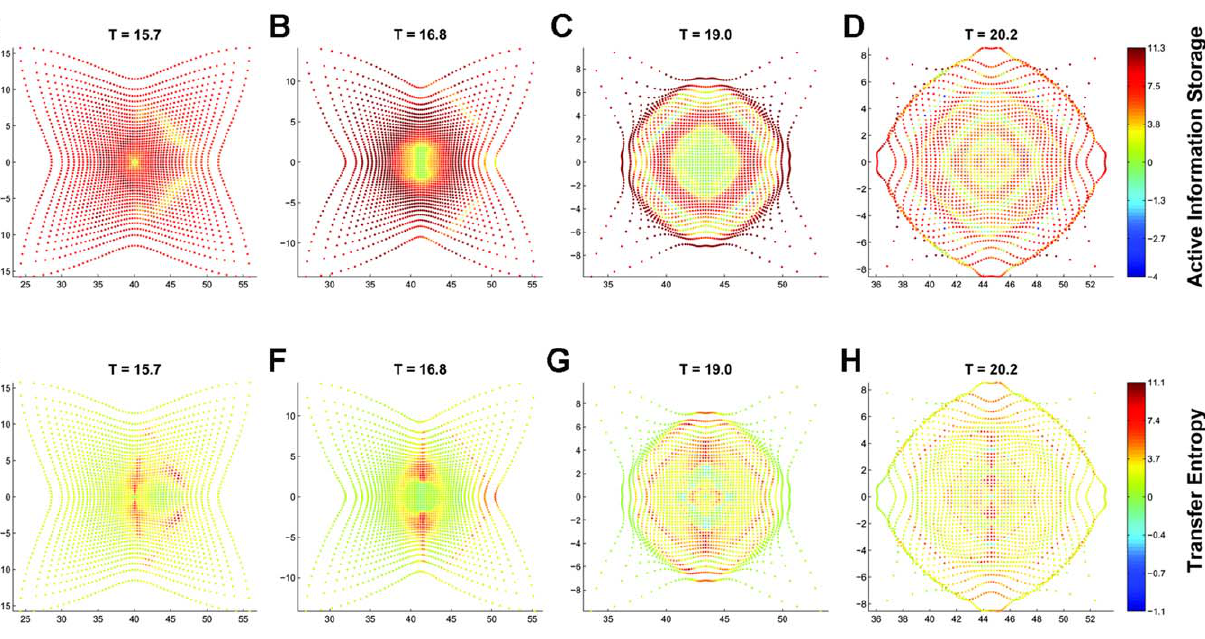
Figure 2. Local information dynamics for a swarm initially in a square configuration. (Top) Local average information storage through the swarm at key time steps. (Bottom) Local average information transfer in a swarm at key time steps. The individuals’ two-dimensional positions are plotted on the x and y axes, and their colours represent the AIS and TE values in bits, as shown by the scale on the colour bar. Note that the axes scales are adjusted, and the colours are scaled differently for positive and negative values.